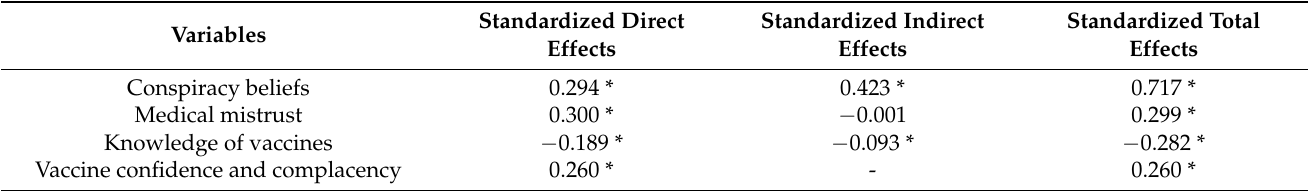
Table 4. Standardized direct effect, indirect and total effect of the variables on vaccine hesitancy ( N =